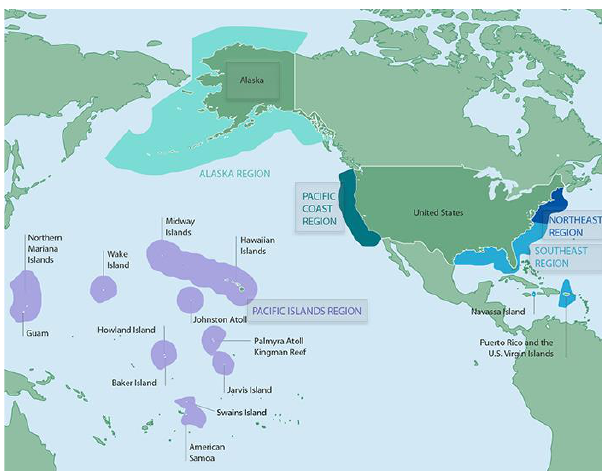
Fig. 1. U.S. EEZ consists of following sub-regions: (a) West Coast; (b) East Coast (Northeast and Southeast regions); (c) Alaska; (d) Gulf of Mexico; (e) Puerto Rico and U.S. Virgin Islands; (f) Hawaii and Pacific Islands. EEZ is defined as a sea zone that extends 370 km (200 nmi) offshore from its coastal baseline. The image is obtained from NOAA National Ocean